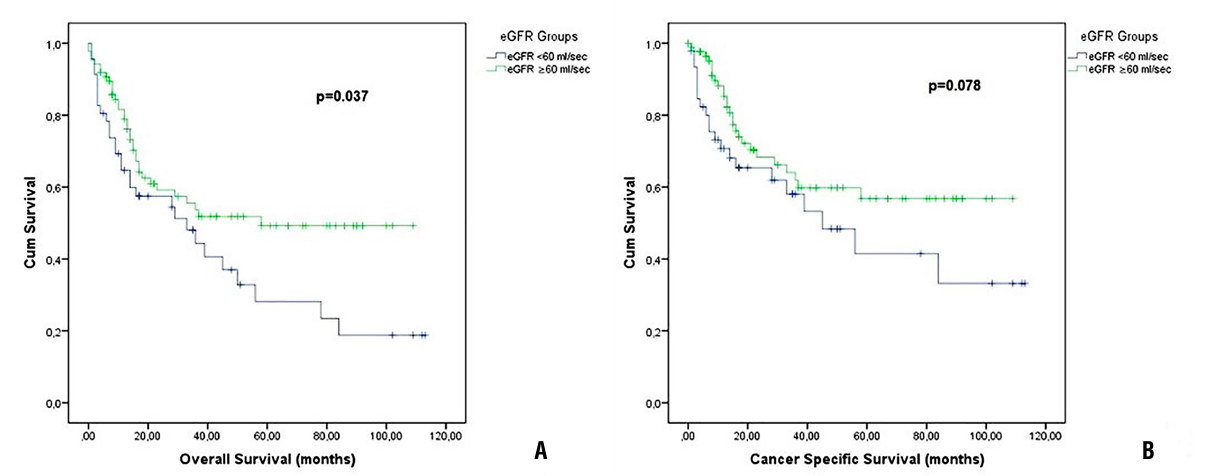
Figure 1 - A) Overall survival plots of Kaplan-Maier analysis. B) Cancer specific survival plots of Kaplan-Maier analysis.